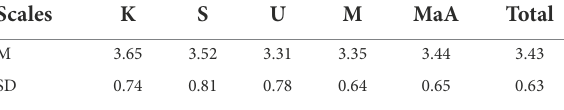
TABLE 1 Descriptive analysis of learner